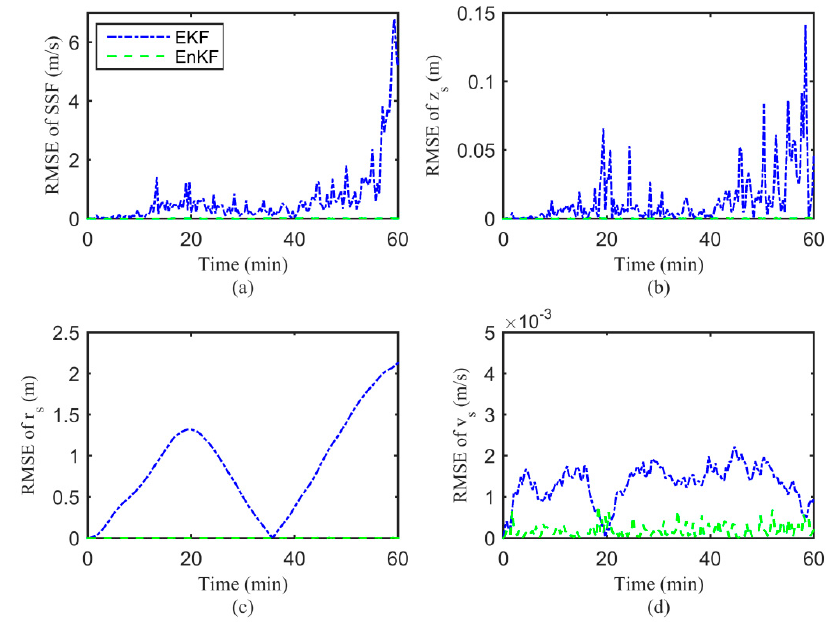
Figure 5. Root mean square error (RMSE) summarizing the performance of EKF (dash-dotted line) and EnKF (dashed line) for the joint inversion. ( a ) SSF source parameters, ( b ) depth, ( c ) range and ( d ) speed.